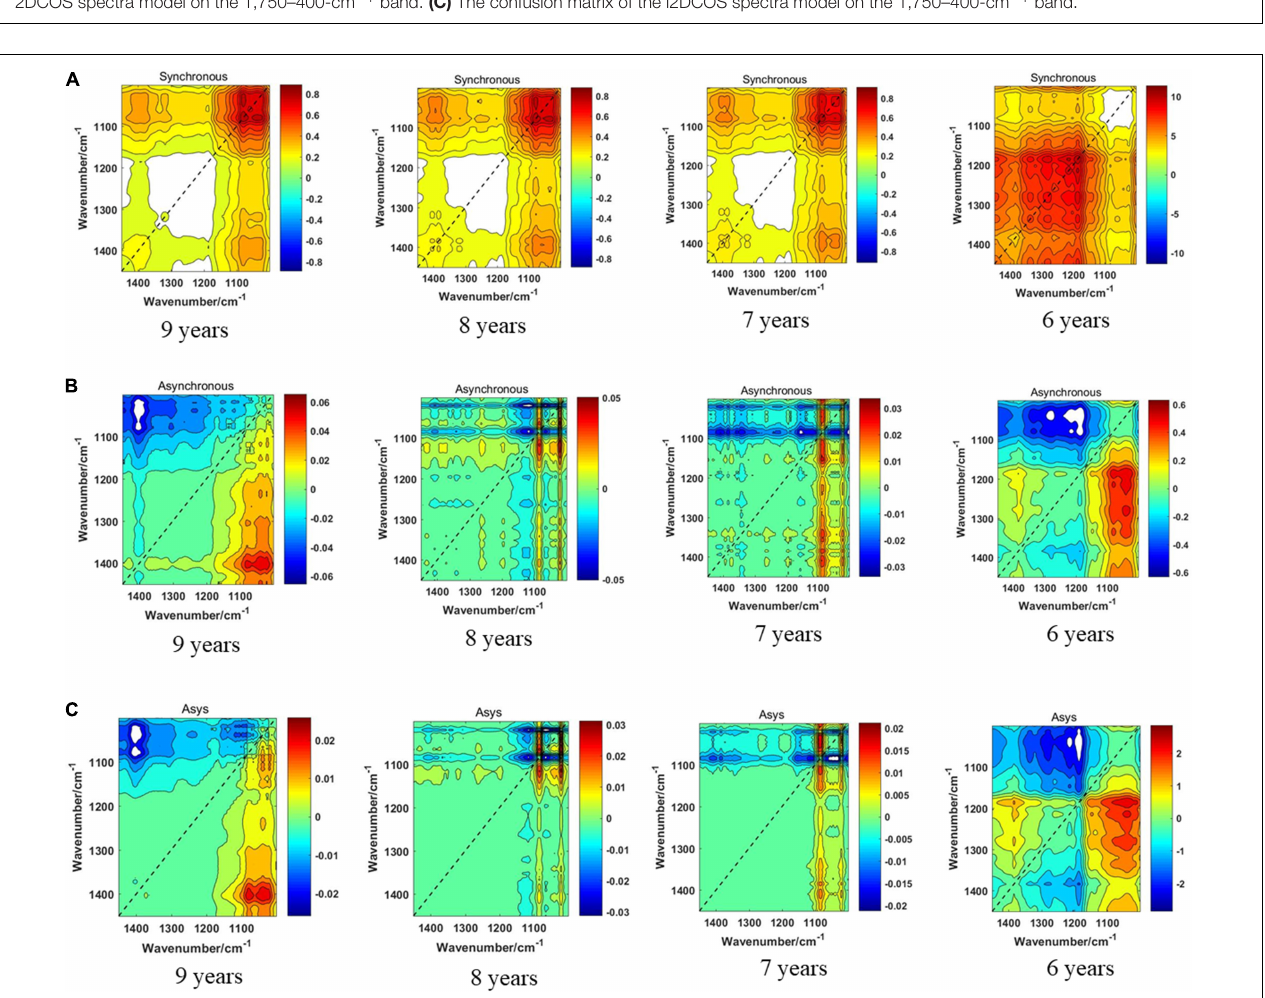
FIGURE 8 | (A) The synchronous 2DCOS spectra of the 1,450–1,000-cm − 1 band. (B) The asynchronous 2DCOS of the 1,450–1,000-cm − 1 band. (C) The i2DCOS spectra of the 1,450–1,000-cm − 1 band.